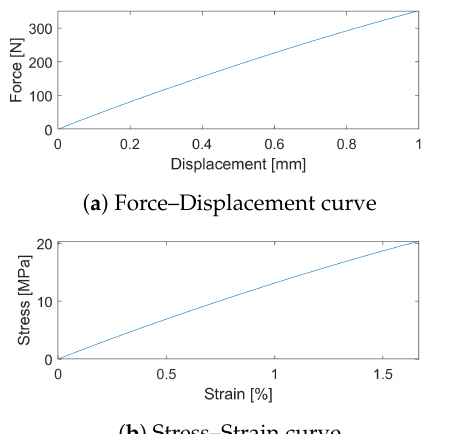
Figure 15. Loading results from the Instrom test machine, resulting in an approximation of the blade’s Young’s